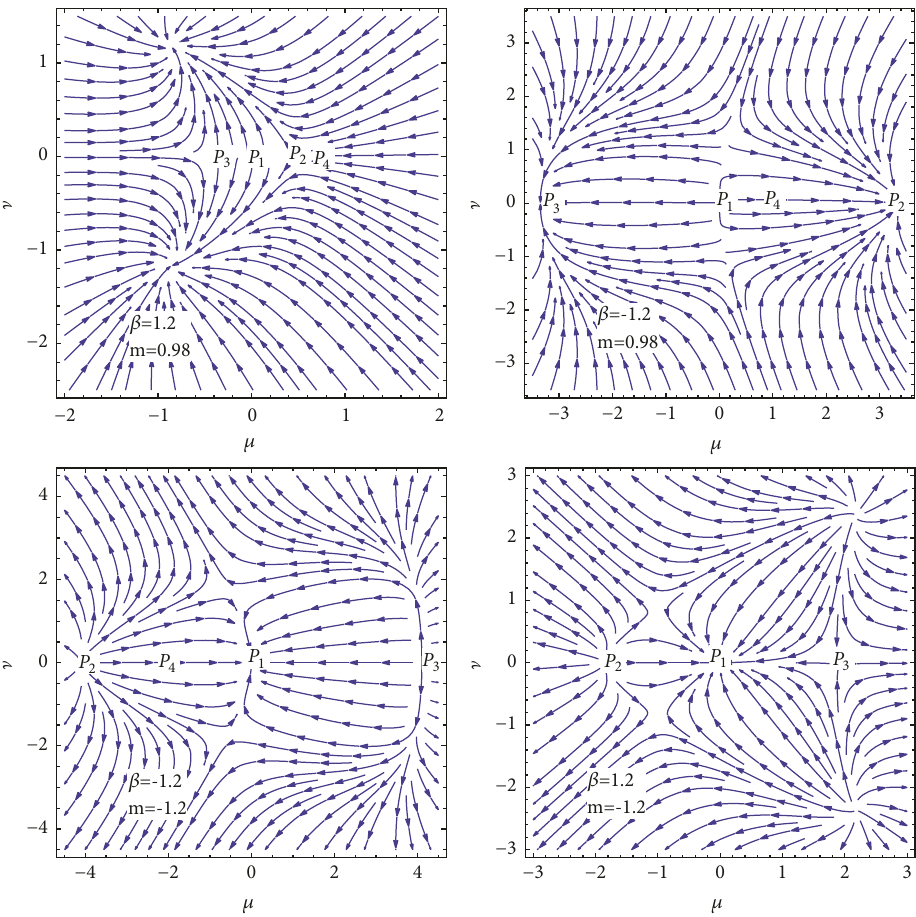
Figure 2: Plots for phantom coupled cosmic model with 𝑄 = 𝛽 ̇𝜎 𝜙 and 𝜆 = 1.5